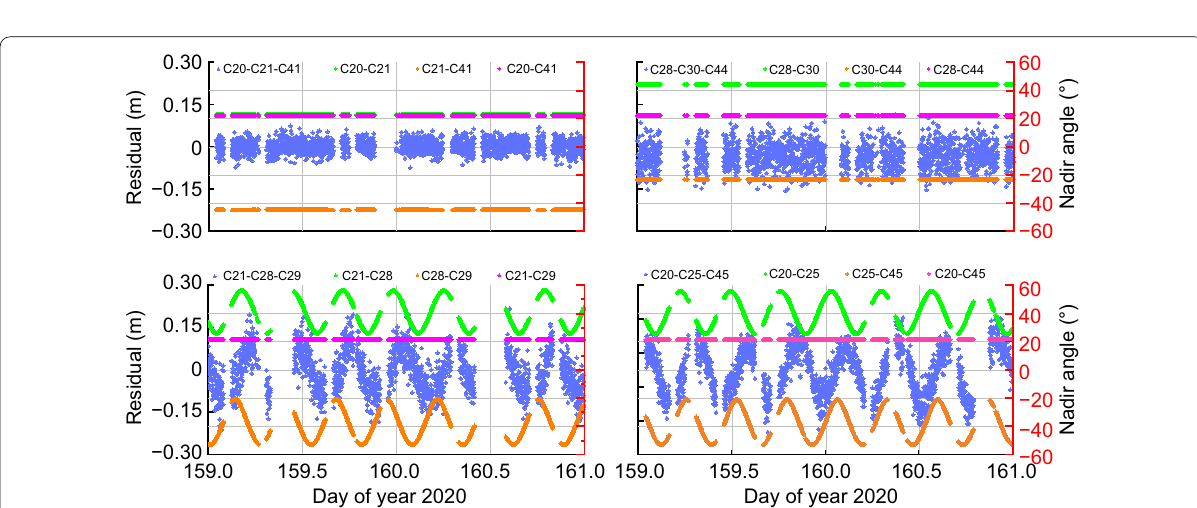
Fig. 7 Misclosures of ISL orbit-free observables for three satellites connected with each other. The green, purple and orange cures represent the nadir angle of each ISL